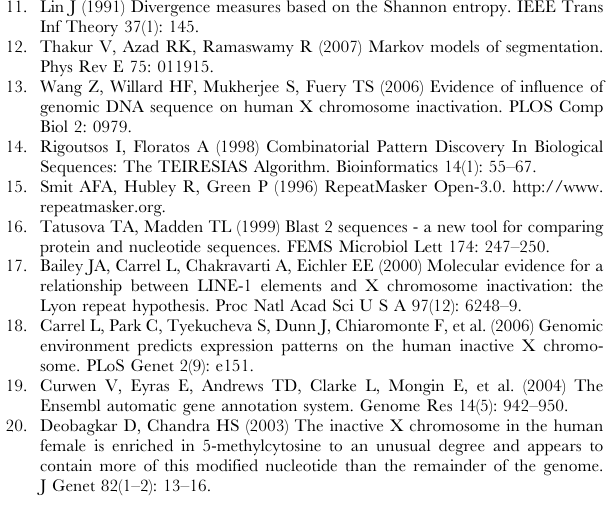
Figure S2 Figures A to I show compositional variation in remaining nine domain pairs listed in Table 1. Table S1 Coordinates of boundaries obtained from six segmen- tation steps. The data is graphically represented in Figure 1. Segmentation steps having more than one JS divergence maximum are indicated by symbol ‘*’. Table S2 Synonymous and non-synonymous substitution rates of gene pairs constituted of XAR genes and their orthologs in G. gallus.